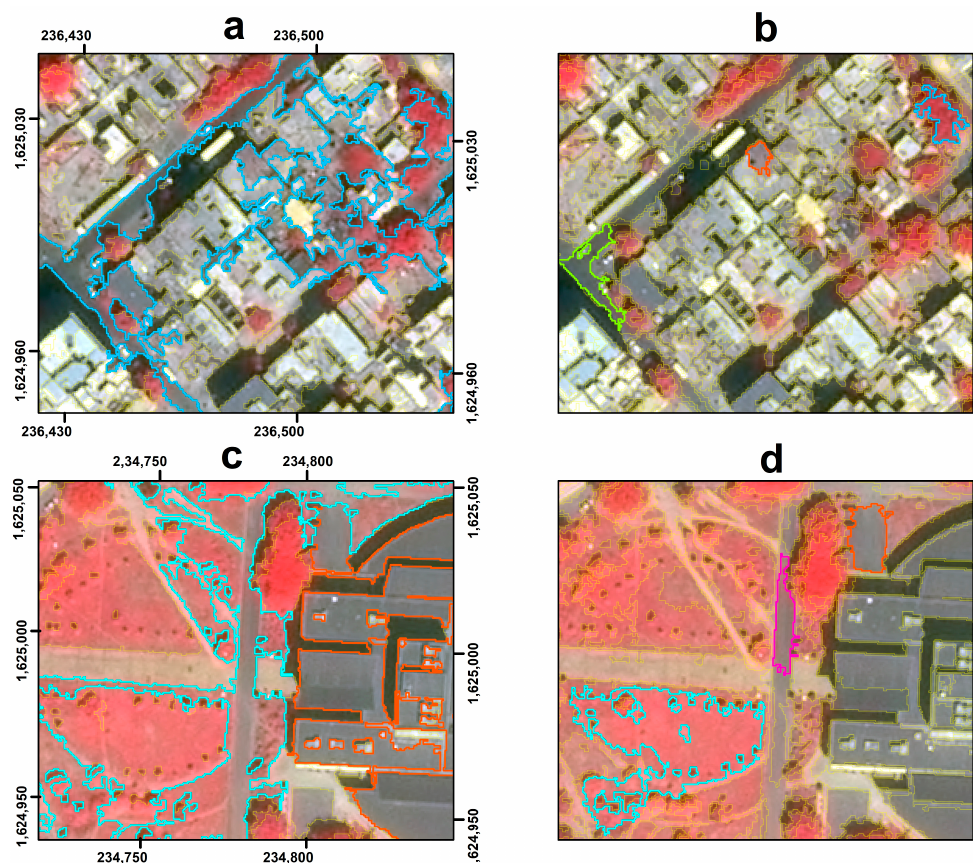
Figure 9. Example of segmentation results for the two ROI. ( a , c ) FT approach, ( b , d ) LOESS approach. Highlighted objects in color other than yellow display undersegmented areas where several LULC classes are mixed for the FT approach, while colored objects in the LOESS case showcase some of the clear improvements as the objects now represent discrete LULC classes (e.g., asphalt, vegetation, building).